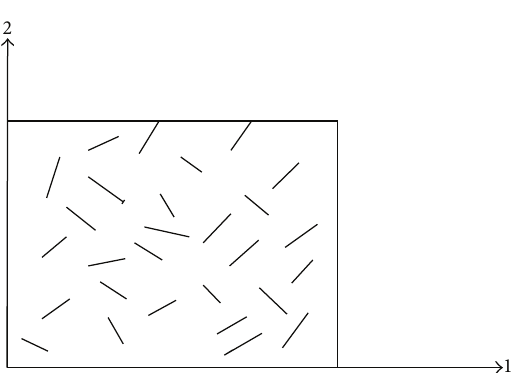
Figure 8: Randomly oriented discontinuous fiber-reinforced